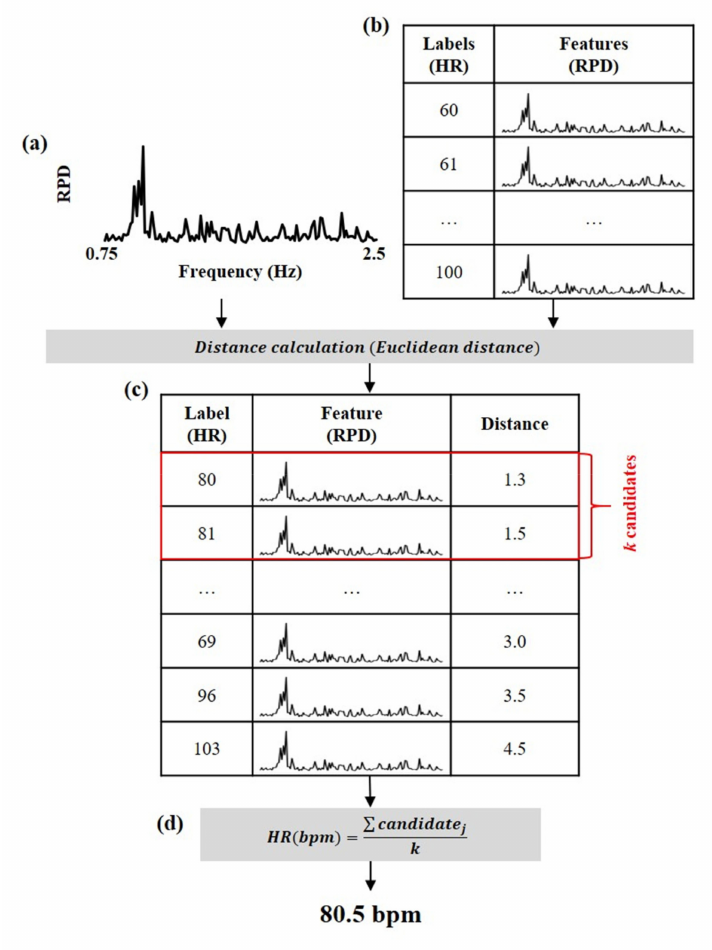
Figure 4. Overview of heart rate estimation using the model. ( a ) The RPD extracted from the facial video, ( b ) the trained model consisting of RPD and heart rate, ( c ) distance calculation between the RPD of the facial video and the RPDs of the model, ( d ) heart rate estimation by averaging the k